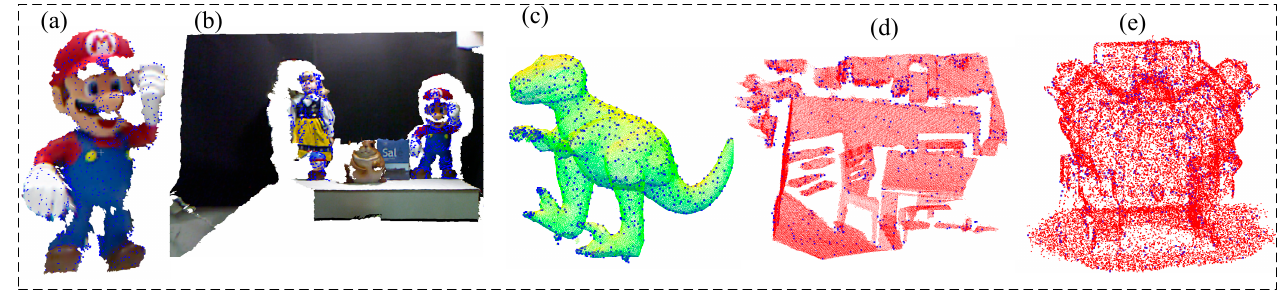
Figure 3. Demonstrate keypoints of K-PPF ( a ) kinect Mario model; ( b ) Kinect scene; ( c ) UWA Trex; ( d ) Redkitchen; ( e ) our lab’s engine.